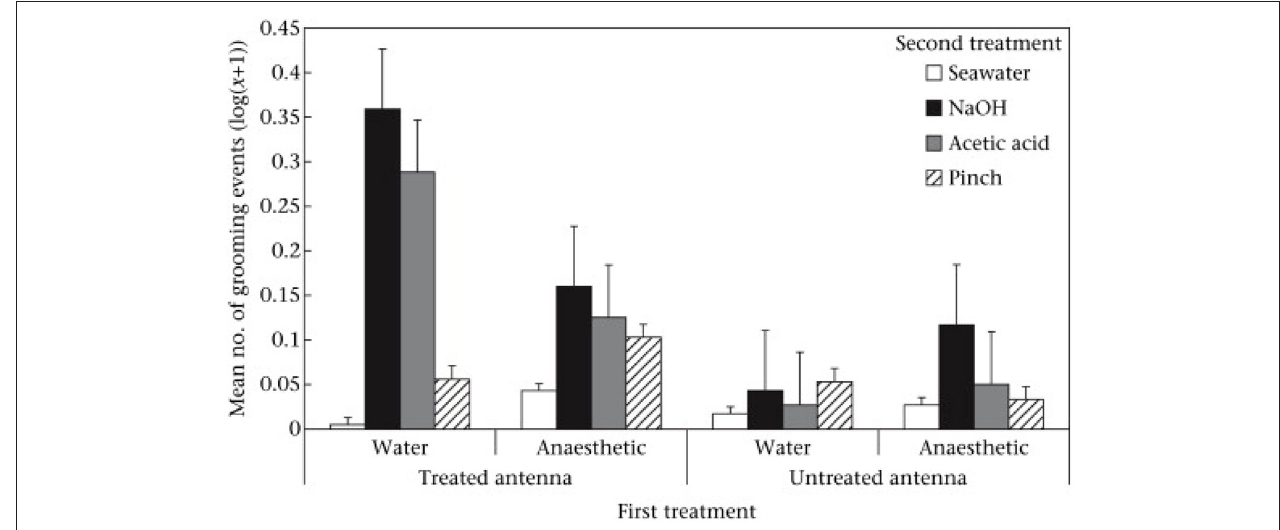
FIGURE 2 | Mean ± SE (log( x + 1)) of grooming of treated and untreated antennae in the second observation. Reproduced with permission from Barr et al.